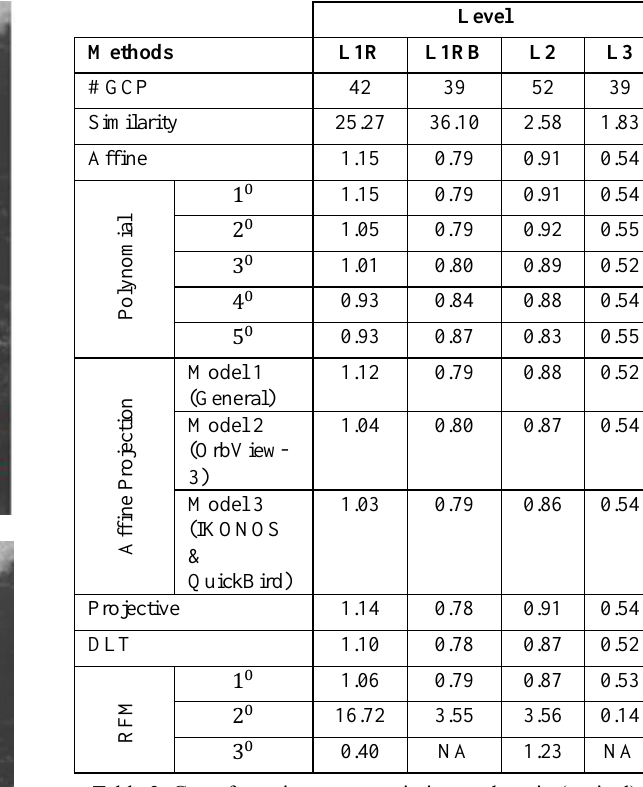
Table 3. Georeferencing accuracy in image domain (±